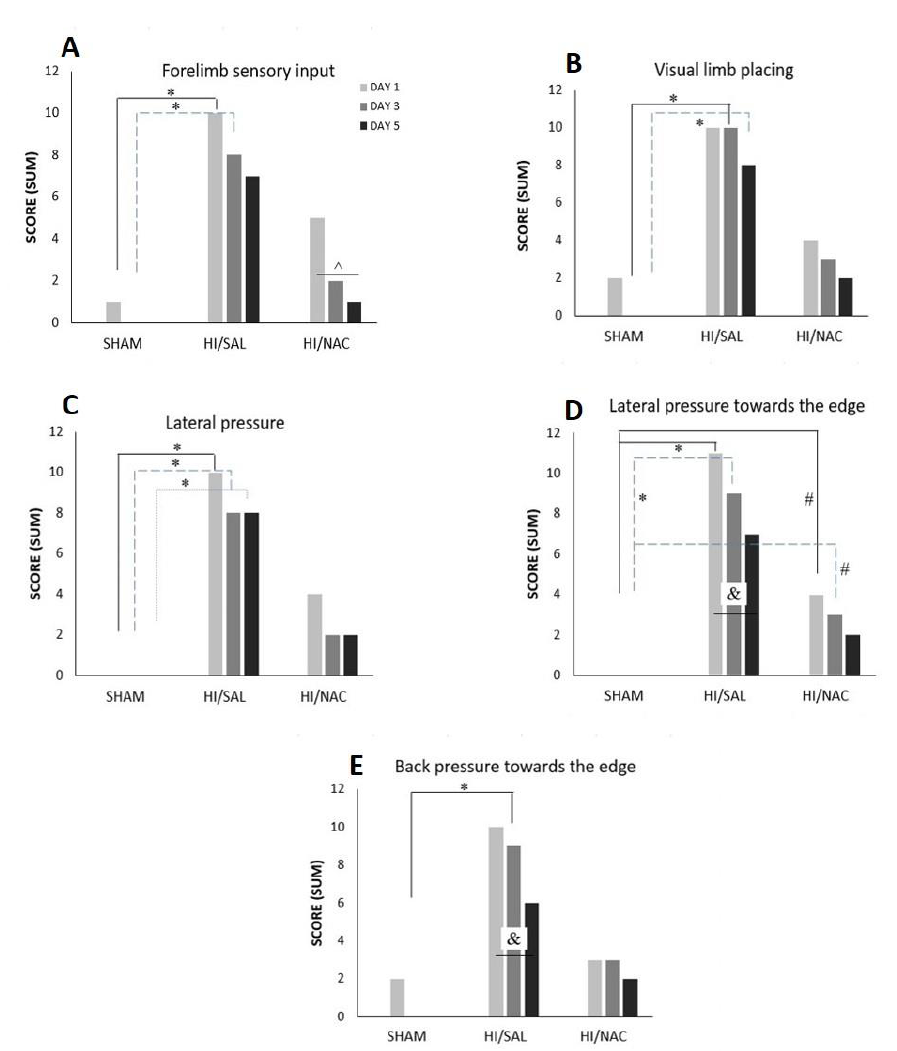
Figure 3. ( A – E ) Performance of SHAM, HI/SAL and HI/NAC groups in limb placing tests during the 3 days of the examination. (*) p < 0.05 HI/SAL vs. SHAM group, (#) p < 0.05 HI/NAC vs. SHAM group, (&) p < 0.05 HI/SAL day1 vs. day5, (ˆ) p < 0.05 HI/NAC day1 vs. day5. Lateral pressure towards the edge: SHAM animals presented with normal reflex from day 1 (4/4), while HI/NAC animals improved from 3/7 in day 1 to 5/7 in day 5, although this difference did not reach statistical significance (Cochran’s Q test, p > 0.05).